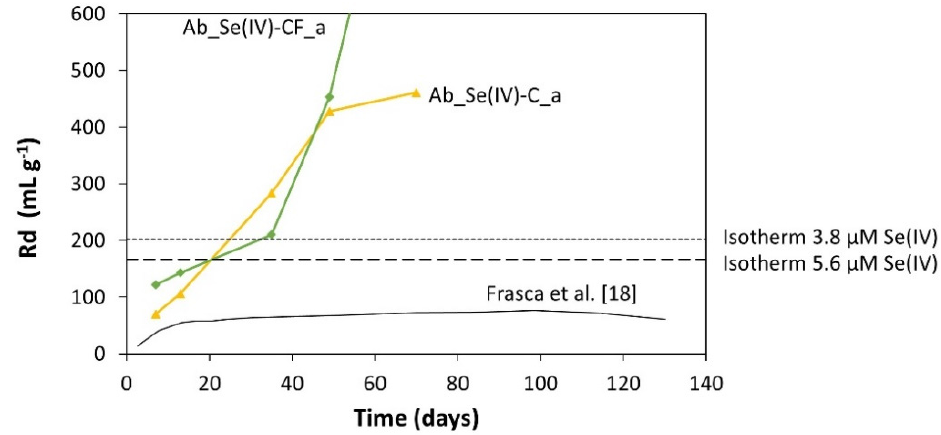
Figure 4. Se(IV) sorption coefficients (Rd) calculated with Equation (1) for the abiotic batch experi- ments Ab_Se(IV)-C_a (yellow) and Ab_Se(IV)-CF_a (green) (details on test conditions in Table 2) compared to Rd measurements from Frasca et al. [18] for Se(IV) sorption onto Opalinus Clay with initial concentration of 100 µM (black full line). The dashed lines represent the Rd calculated for the abiotic batch experiments from the 2-site Langmuir isotherm of [18] (Equations (1) and (2); Table 3) for equilibrium aqueous concentrations of 5.6 µM and 3.8 µM Se(IV), which encompass the range of concentrations measured in the batch experiments Ab_Se(IV)-C_a and Ab_Se(IV)-C_b after 70 days. Note, the Rd calculated from the Se(IV) concentration of Ab_Se(IV)-CF_a at 70 days is 1085 mL g − 1 and plots outside the scale of the figure.